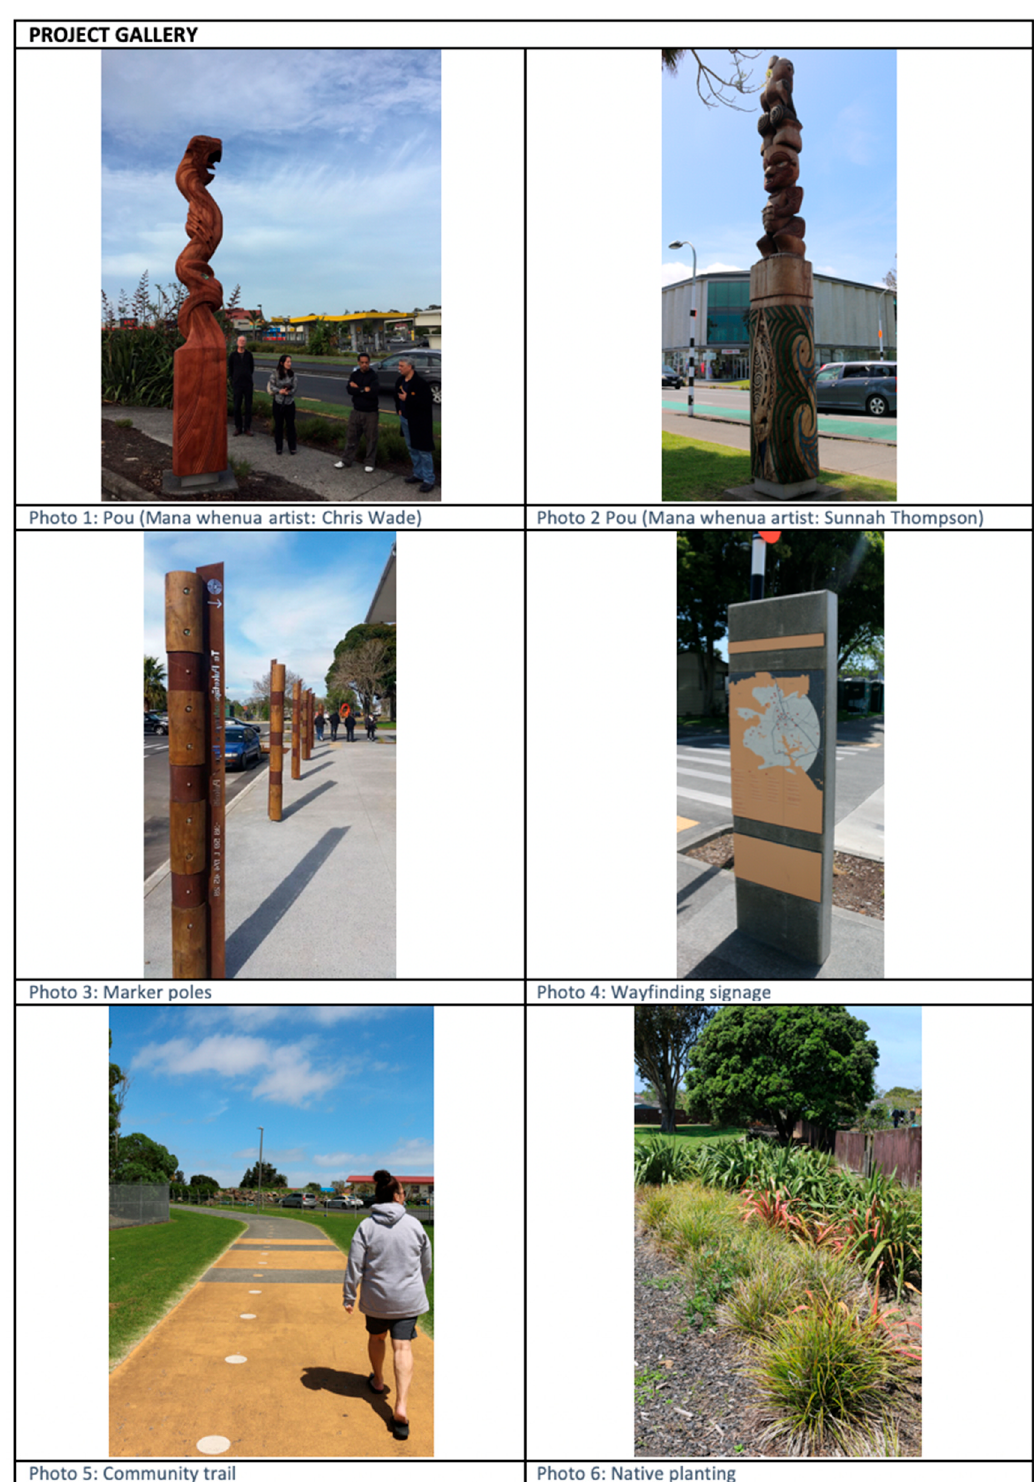
Figure 3. Te Ara Mua—Future Streets Photo Gallery of Mana Whenua Outputs